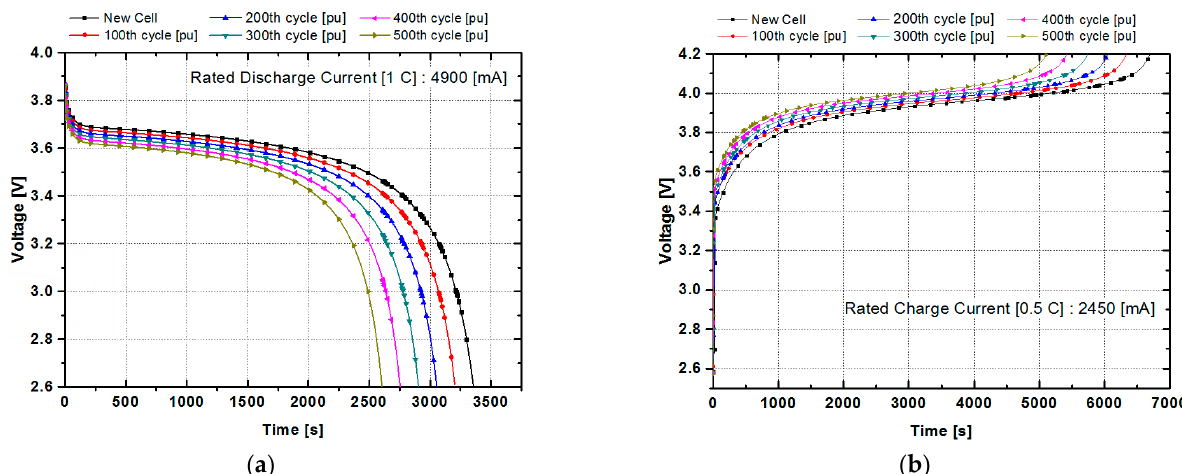
Figure 2. The charging and discharging characteristic curves of the lithium-ion battery: ( a ) battery characteristics using a 1 C discharging current according to the battery aging condition (cycle number) and ( b ) battery characteristics using a 0.5 C charging current according to the battery aging condition (cycle number).